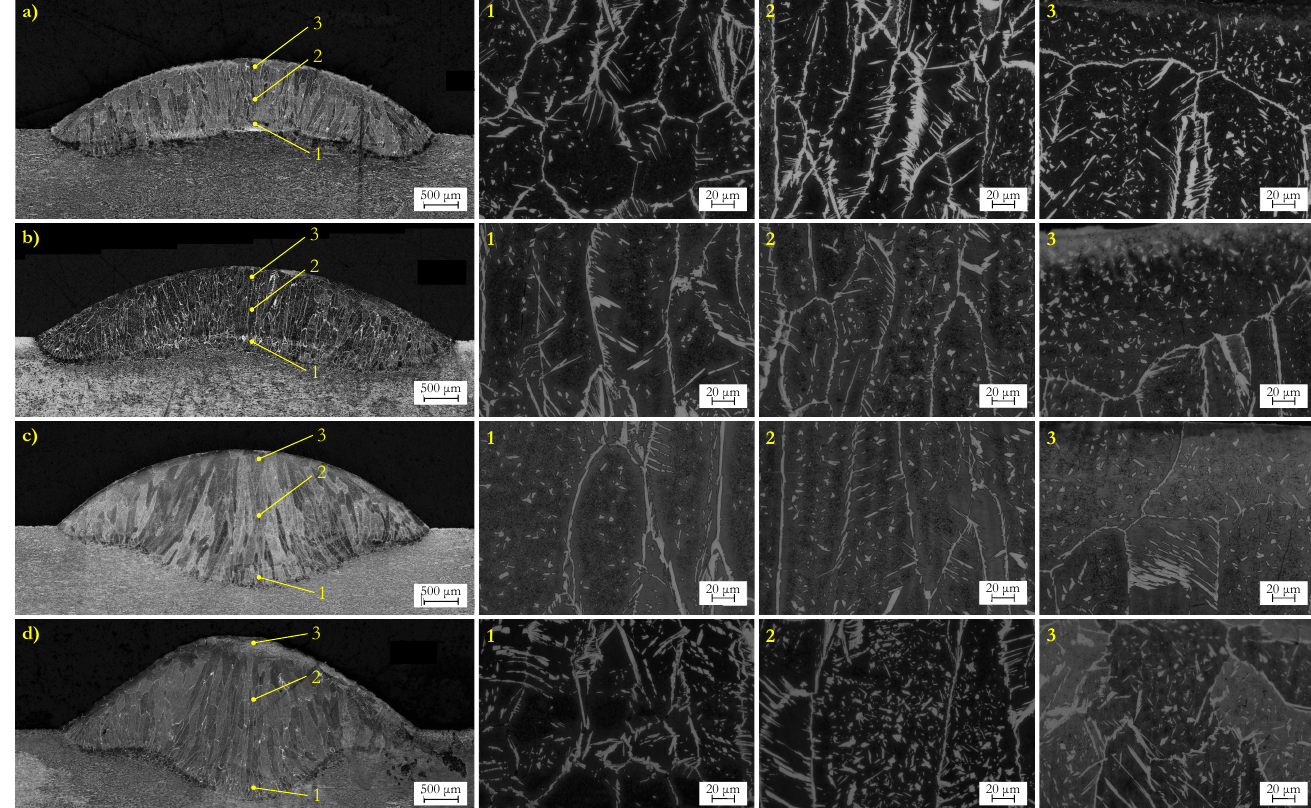
Figure 8. The cross-sections of the beads produced with the medium laser power and different levels of hot-wire: ( a ) L0— cold wire, ( b ) L1—low hot-wire level, ( c ) L3—medium hot-wire level, ( d ) L6—high hot-wire